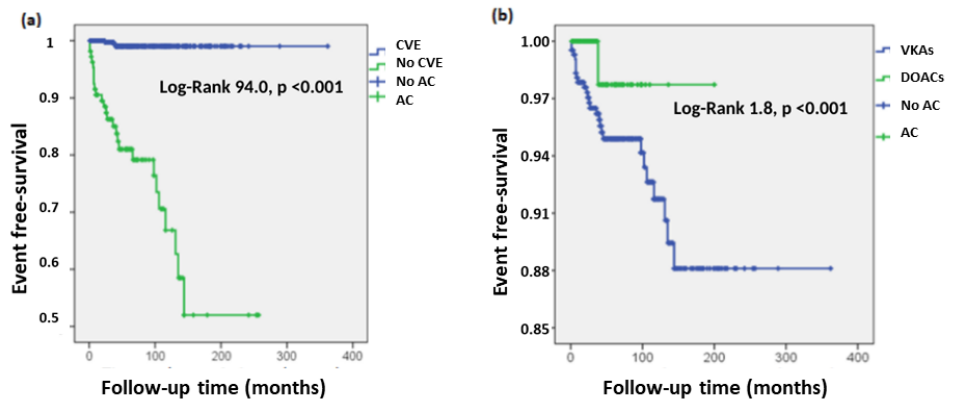
Figure 1. Effect of (a) previous cerebrovascular events and (b) the use of coumarins compared to DOACS were associated with a higher risk of ischemic and embolic events in the Cox regression model. Abbreviations: DOACS: direct-acting oral anticoagulants. CVE: cerebrovascular event. AC: adjustment for censoring. VKAS: vitamin K antagonist anticoagulants.